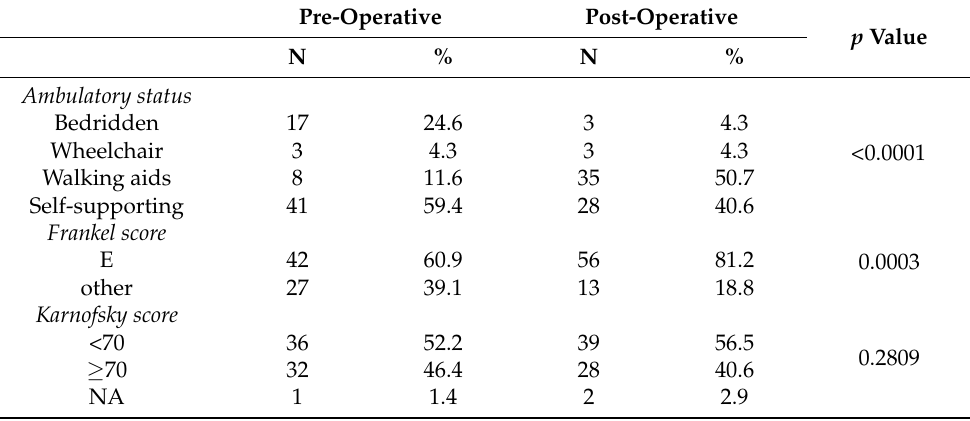
Table 4. Comparison between pre-operative and post-operative patient